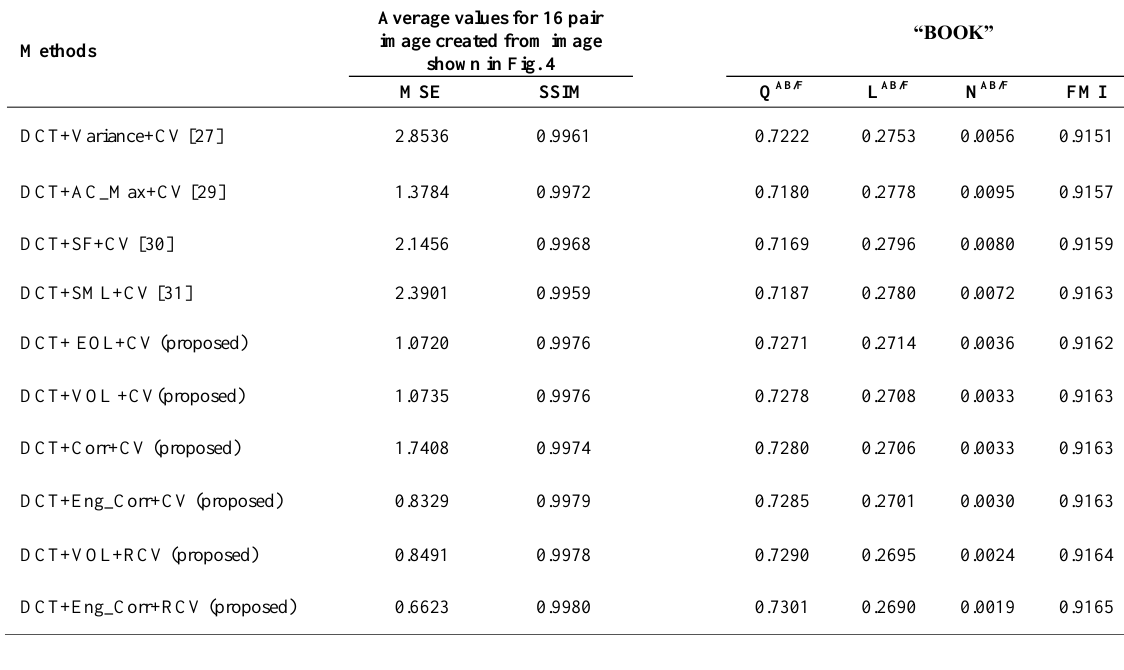
Table 3. Comparison between CV and RCV post-processing algorithms.